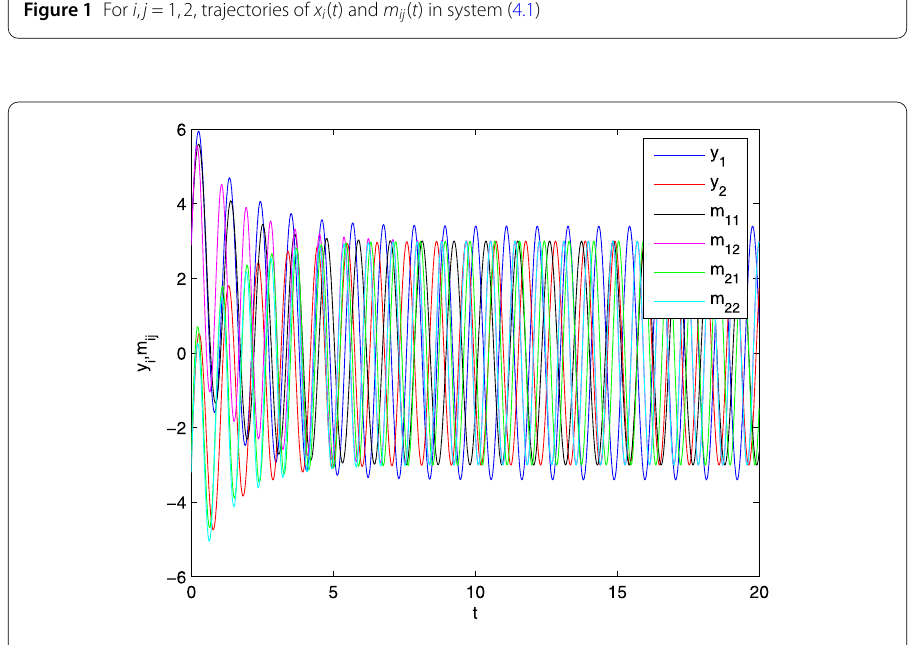
Figure 2 For i , j = 1,2, trajectories of y i ( t ) and m ij ( t ) in system